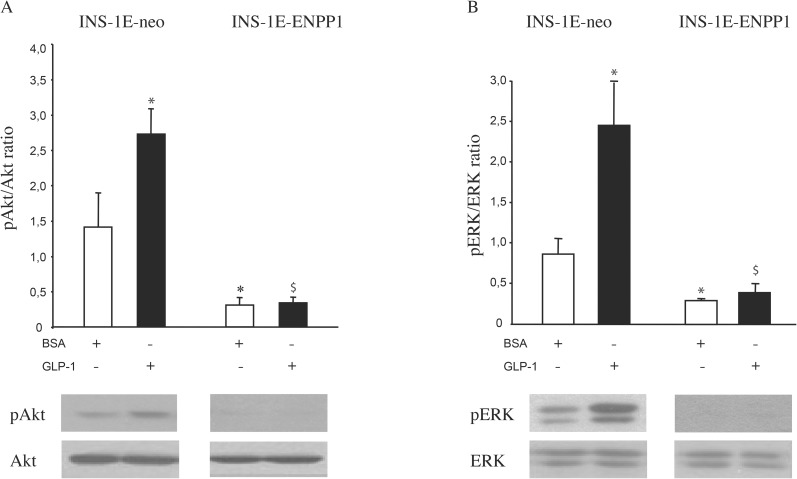
GLP-1 effects on phosphorylation of Akt and ERK 1/2.Phosphorylation of Akt and p-Akt/Akt ratio (panel A) and ERK 1/2 and the p-ERK/ERK ratio (panel B) was evaluated by western blot analysis in INS-1E. Cells were serum-starved for 12 hours and then incubated (2 hours at 37°C) in the presence of BSA or GLP-1 (100 nmol/l). Values are means ± S.D. of four independent experiments. (* p<0.05 compared with BSA treated INS-1E-neo cells; $ vs INS-1E neo GLP-1 100 nM).